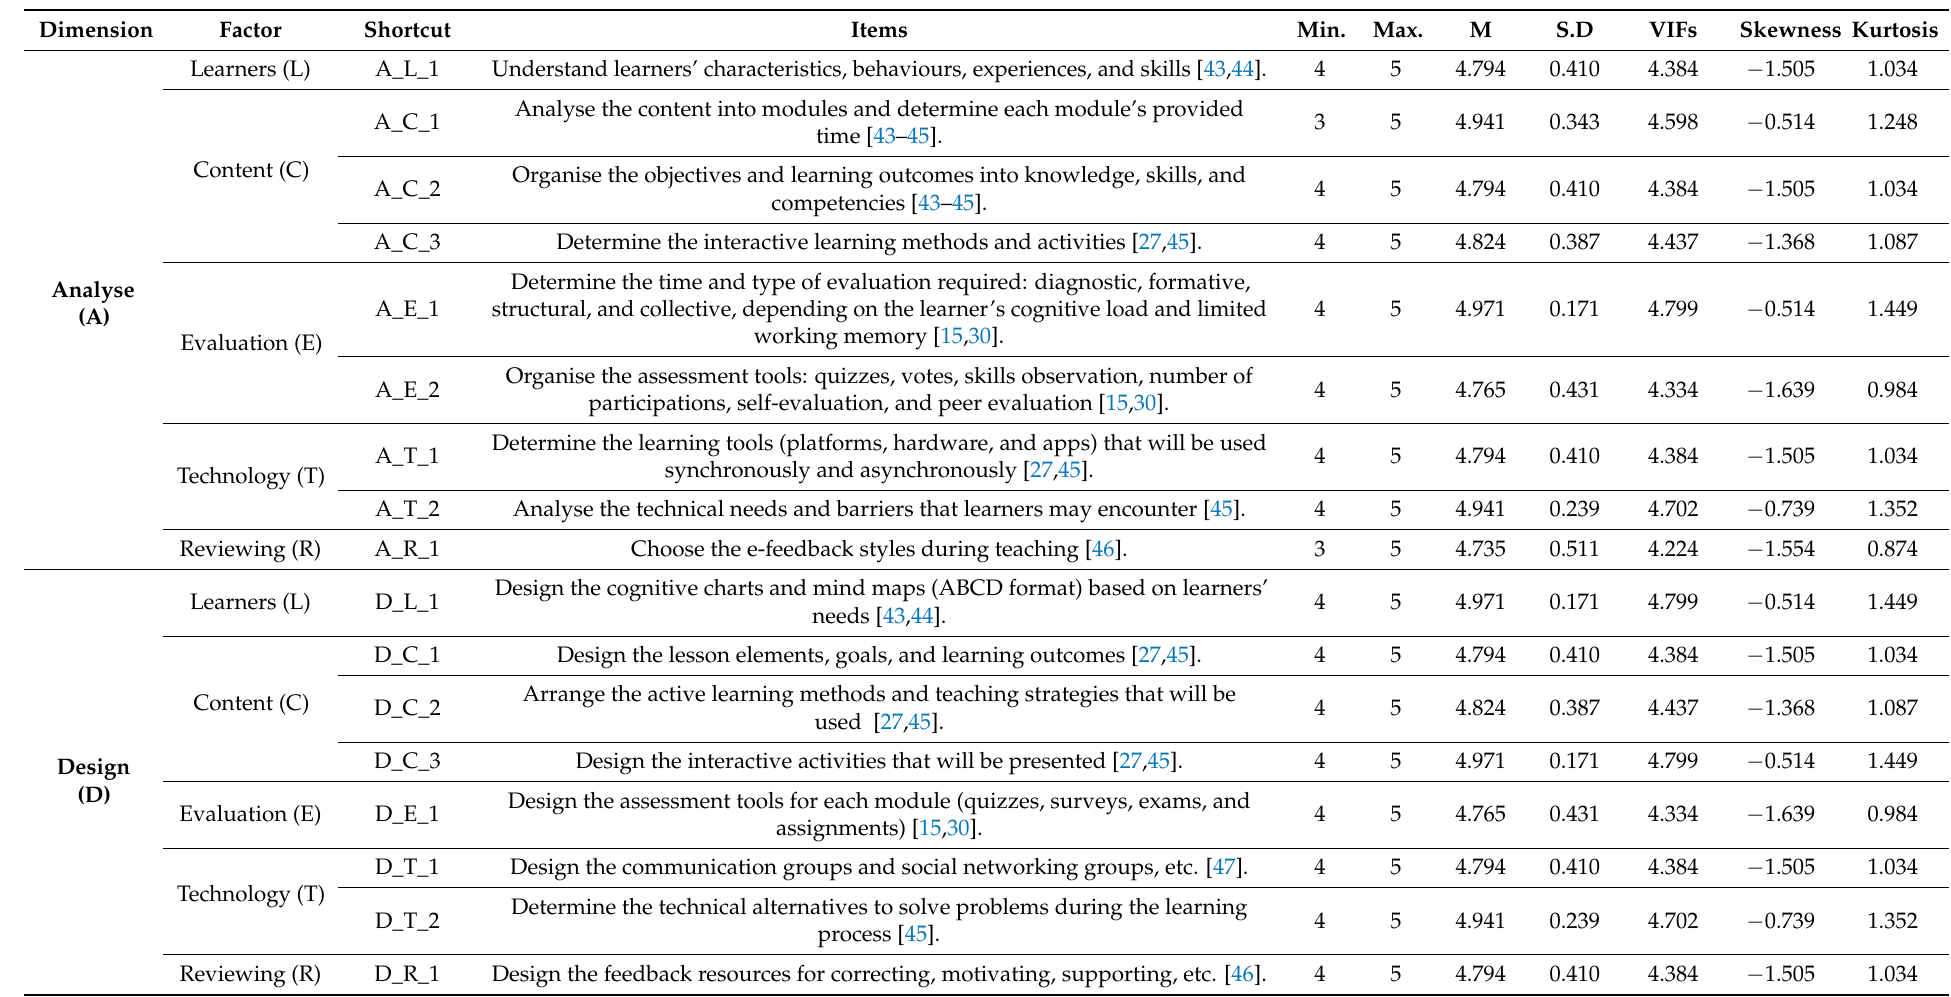
Table 2. Descriptive statistics of the model factors ( n =